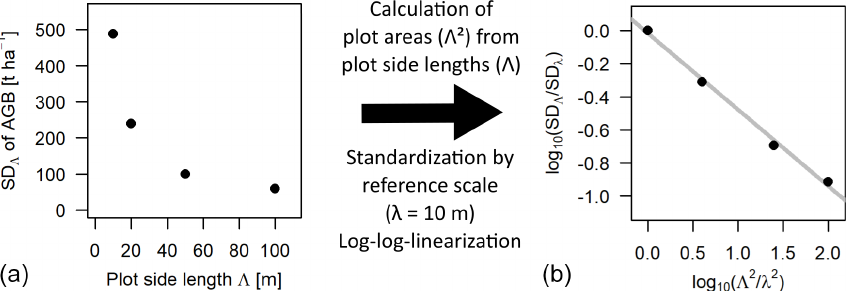
Figure 1. Scale dependence of the standard deviation (SD) of the distribution of aboveground biomass (AGB). Panel (a) shows the SD values at each scale ( (cid:51) ) plotted over the respective plot side lengths (cid:51) . Panel (b) shows the scaling relationship using plot areas ( (cid:51) 2 instead of (cid:51) ) and after standardizing with 10m as the reference scale ( λ ), as well as plotting the values in a log–log linear way. The slope of the grey regression line is the scaling exponent κ